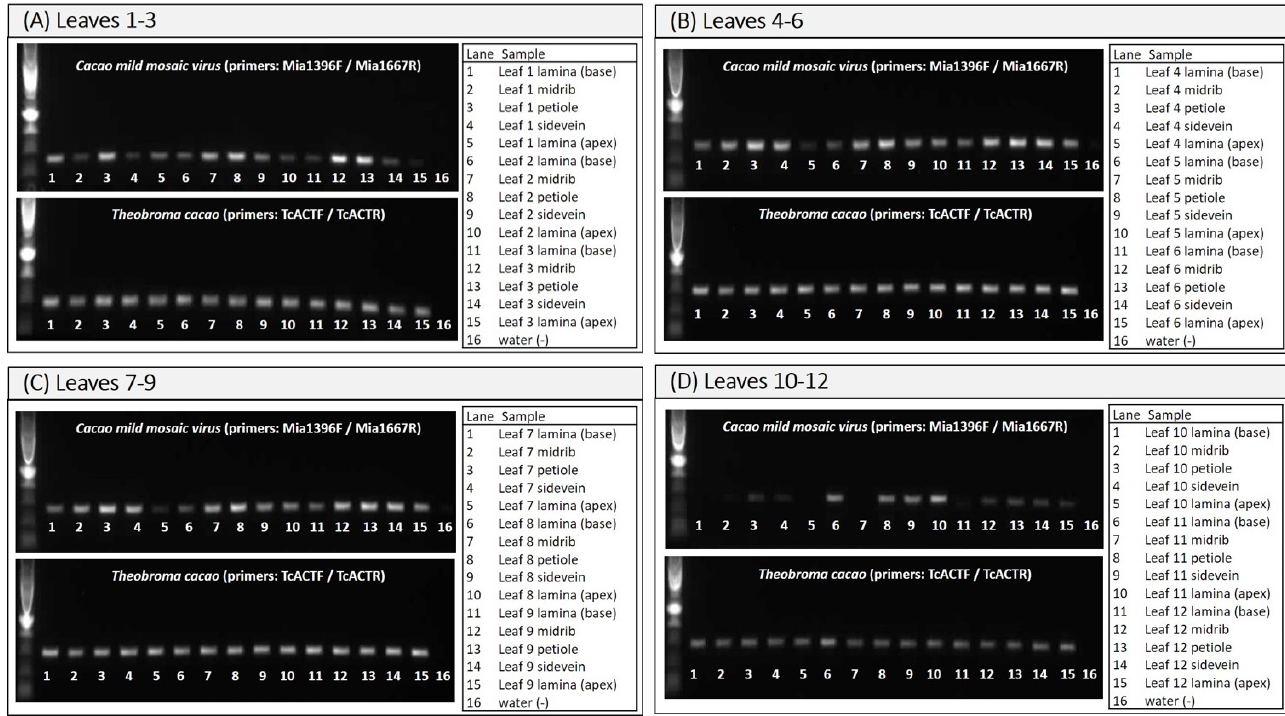
Figure 5. Amplification products using virus-specific (top rows) and cacao-specific (bottom rows) primers in leaf tissues (lamina (base), midrib, petiole, sidevein, lamina (apex)). Intensity of amplicon corresponds to PCR product concentration/titer (data in File S1).